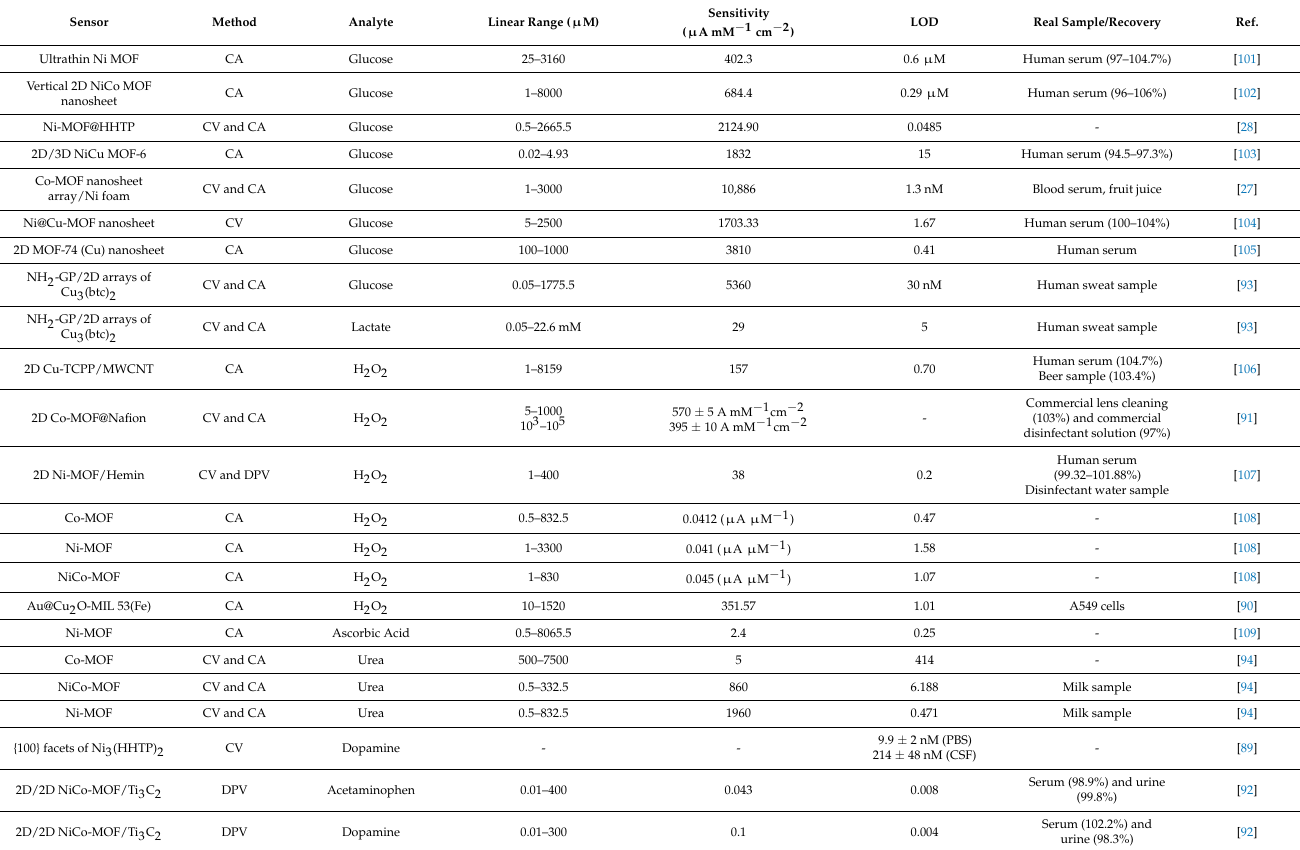
Table 3. Summary of 2D ‐ MOF based electrochemical biosensors.